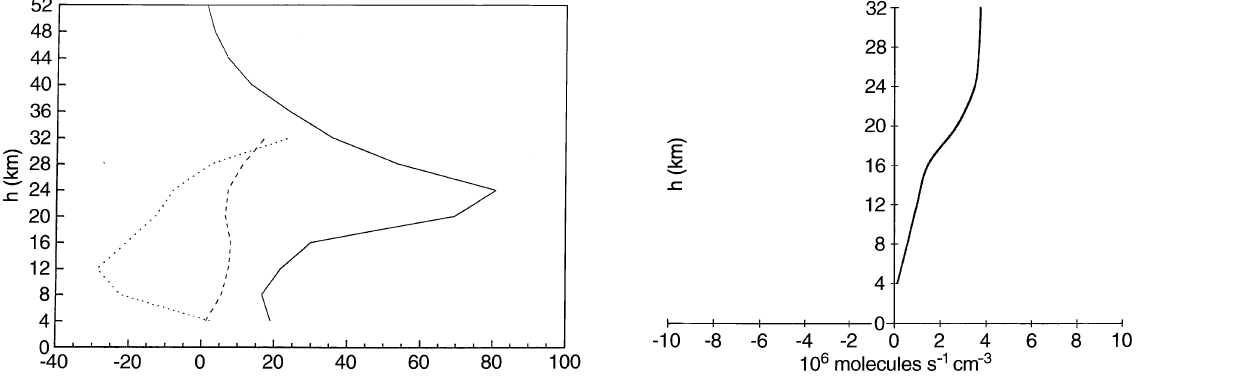
Fig. 12. 5 December 1993; contribution of horizontal-velocity diver- gence to the local variation of the ozone concentration as a function of